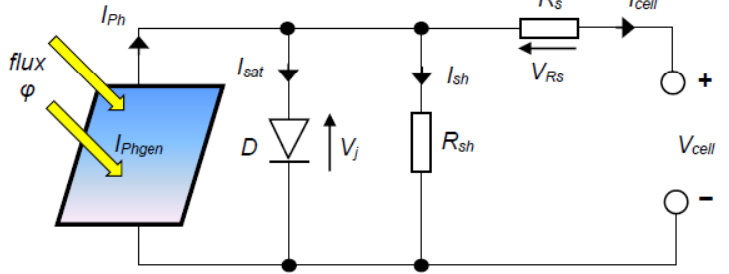
Figure 1. Single-diode equivalent circuit model of the PV cell; I Phgen — photocurrent generator. Resistances R s and R sh symbolize parasitic phenomena occurring in the PV cell. The